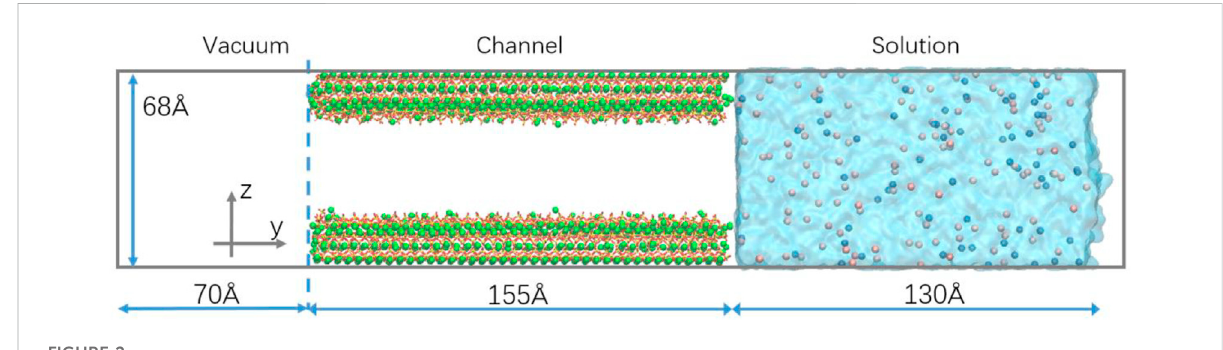
FIGURE 2 The transport model. (The light blue membrane represents the water molecule. The pink and blue balls represent the cation and the NO 2 − ,